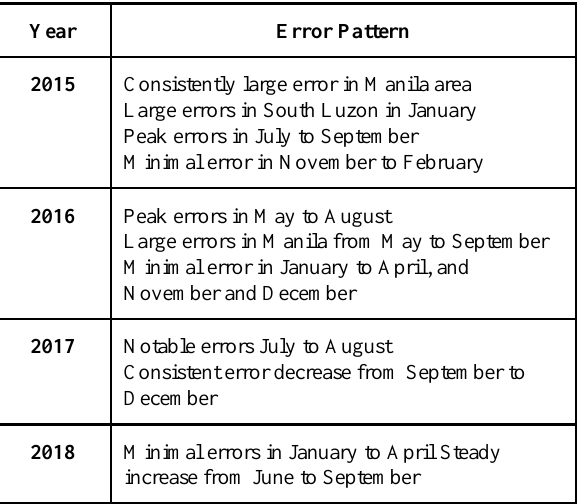
Table 3. Summary of the observed CT1 error patterns per year.